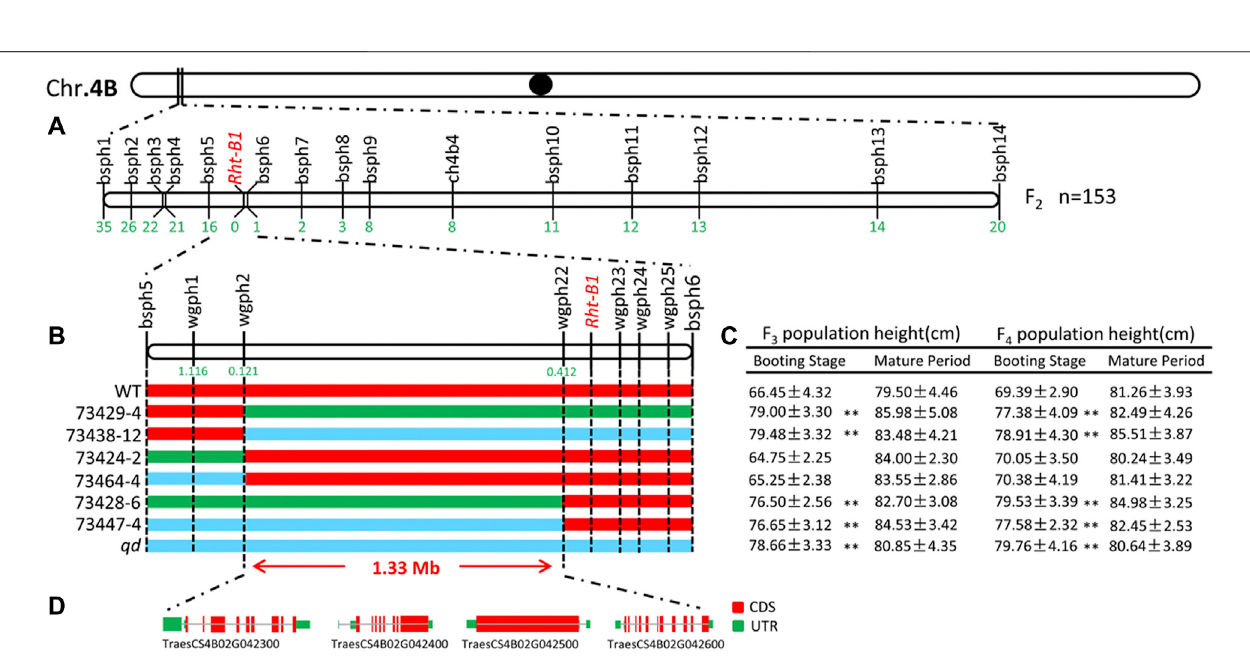
FIGURE 5 | QTL mapping results (A) Results from the WT/ qd F 2 population; (B) results from the BC 3 F 2 ( qd /WT//WT///WT////WT) population.